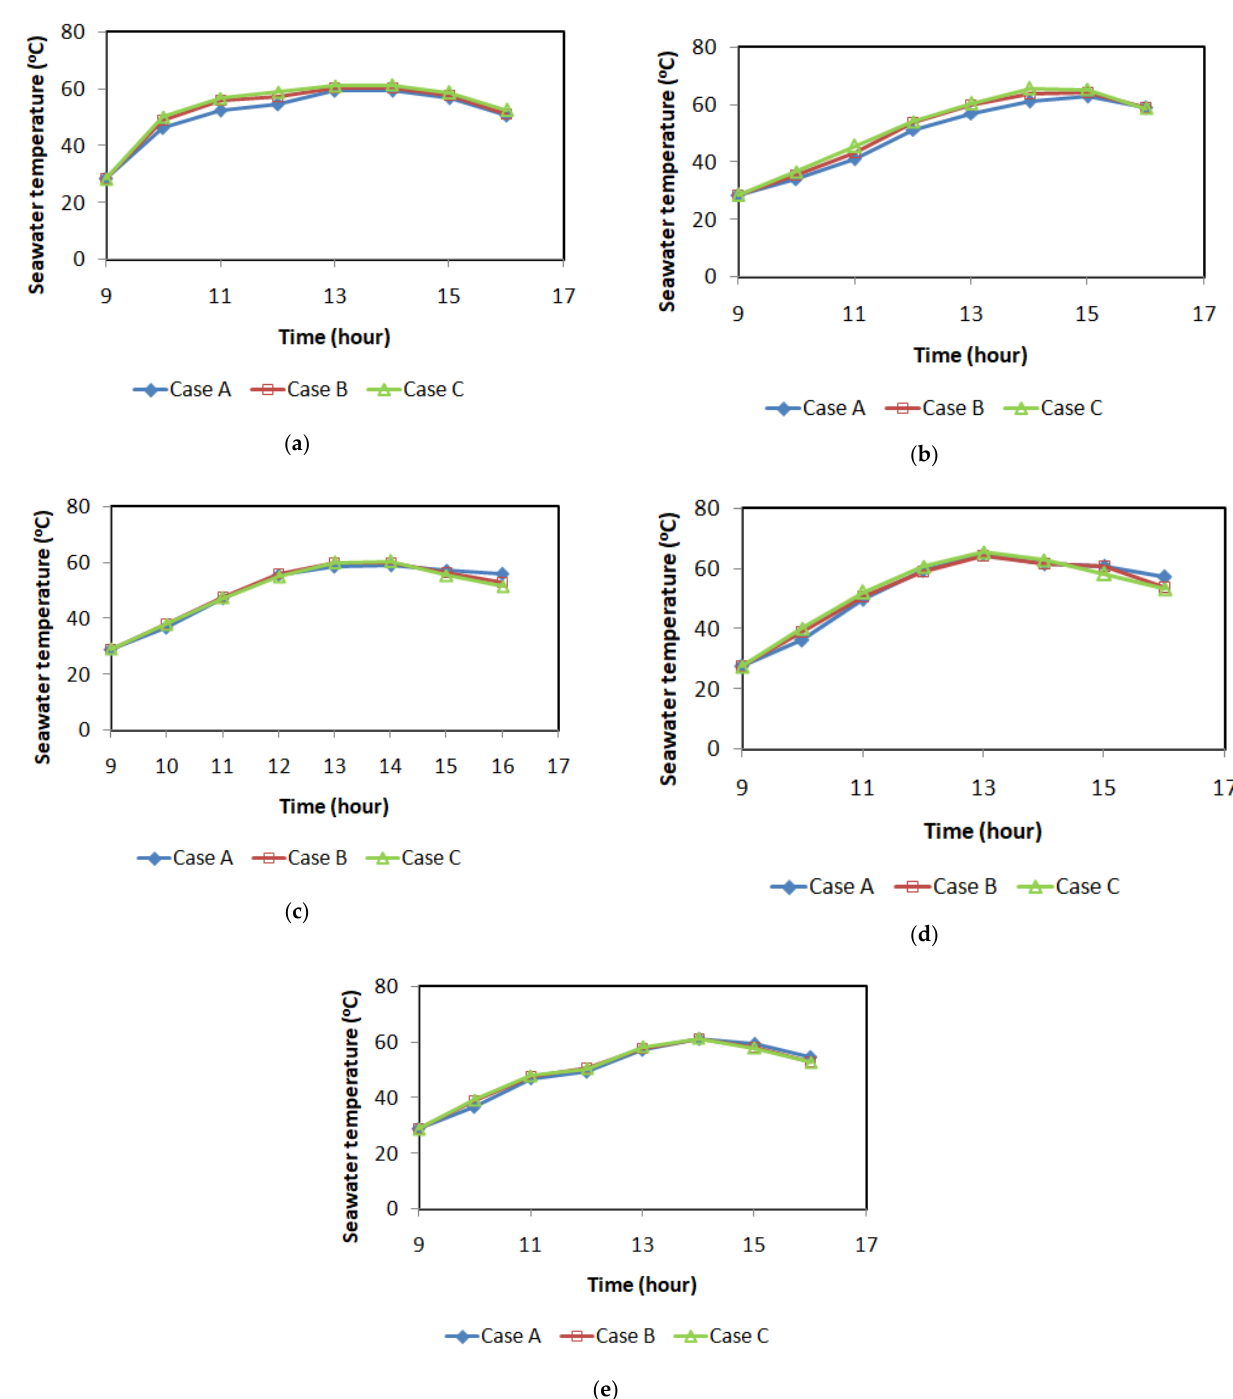
Figure 5. Relationship of seawater temperatures and observation time for five days: ( a ) Day 1, ( b ) Day 2, ( c ) Day 3, ( d ) Day 4, and ( e ) Day 5.